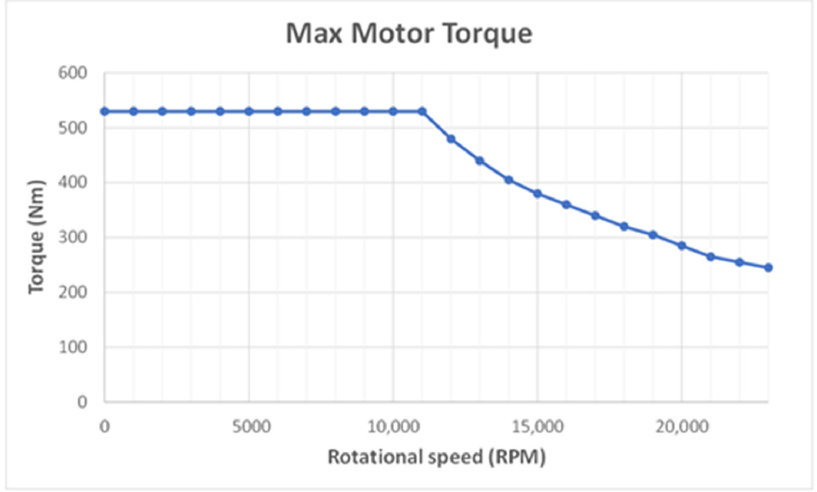
Figure 12. Maximum motor torque vs. motor RPM. The graph is relating to the hypercar electric motors in maximum admission condition.